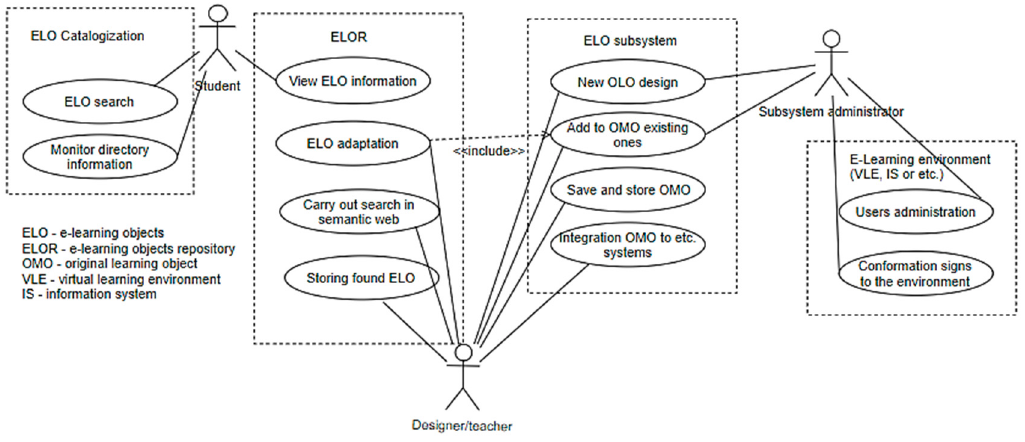
Figure 4. Use case diagram on the ELO design and adaptation on the platform.